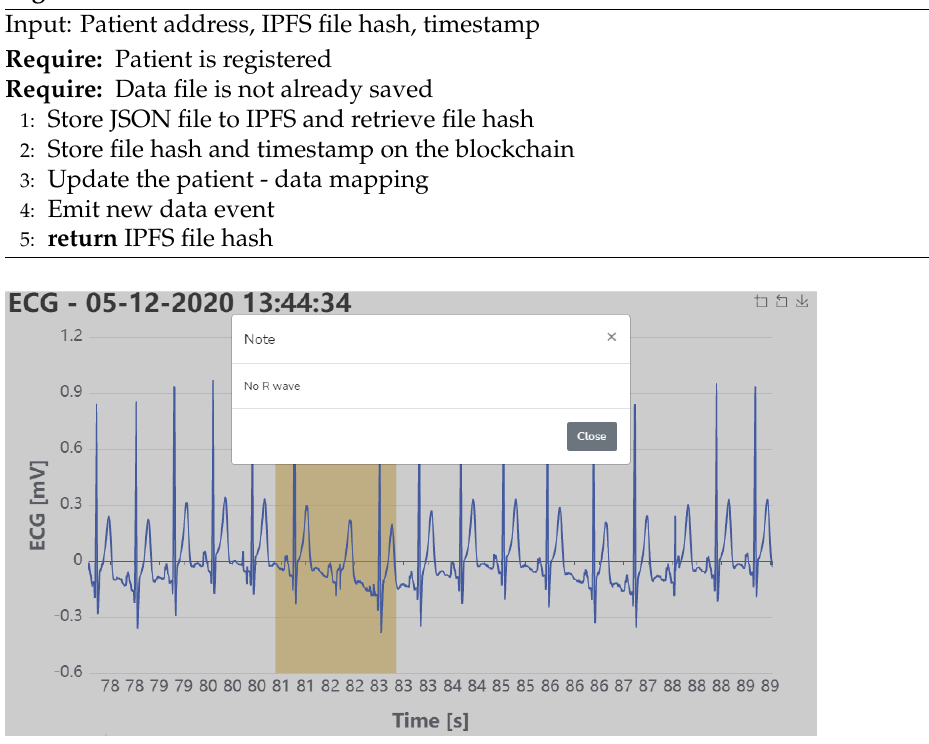
Algorithm 3 New data function